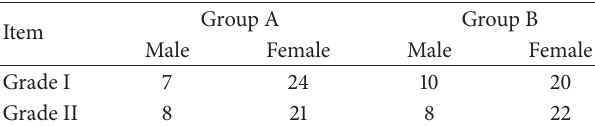
Table 1: Grades and severity of acute cholecystitis in both groups A and